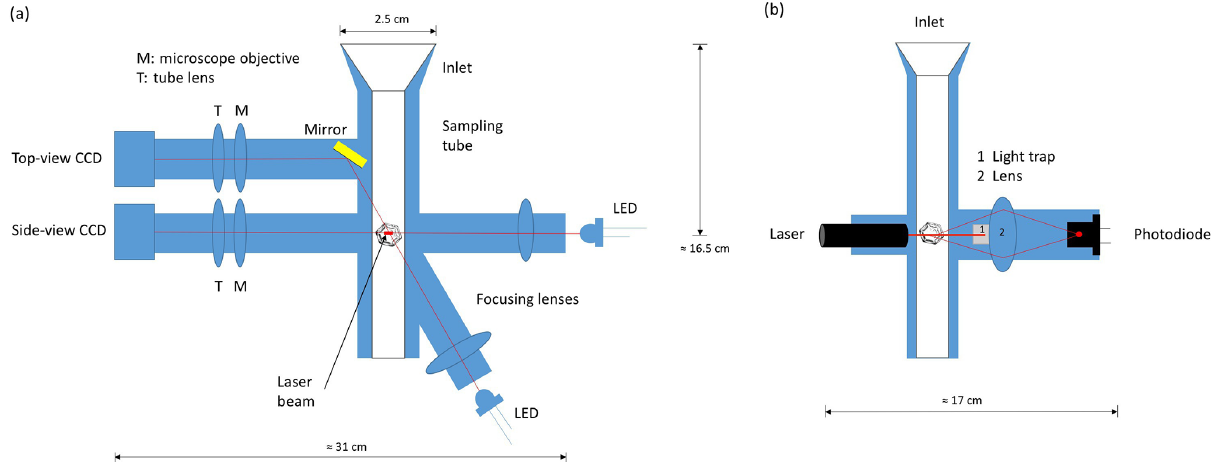
Figure 1. Schematic cut views of the setup of D-ICI. (a) Cut through a plane defined by the optical axes of the imaging optics showing inlet, sampling tube, and the side- and top-view imaging optics and illumination; (b) perpendicular cut showing laser detection consisting in laser, light trap, lens for collection of scattered light, and photodiode. In both panels, the optical cell with the sensing volume at its centre is indicated by the image of an ice crystal (not to scale).